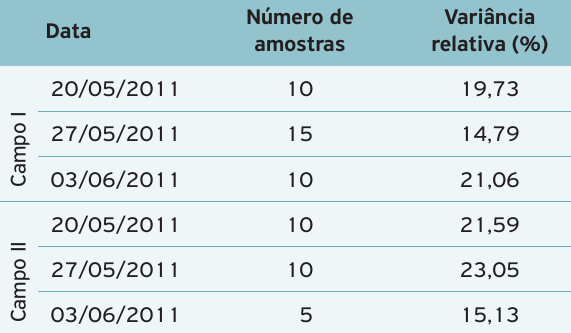
Tabela 4. Número de amostras de Empoasca kraemeri necessárias para uma variância relativa menor ou igual a 25%. Fortaleza, Ceará,